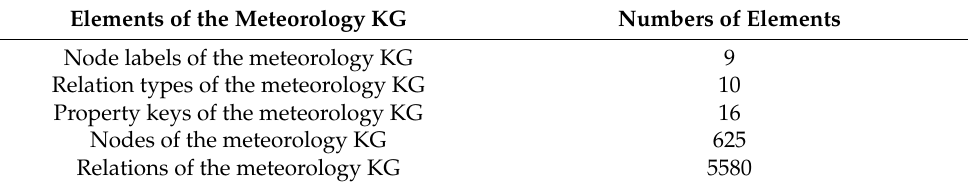
Table 9. Statistical details of the meteorology knowledge graph (KG)